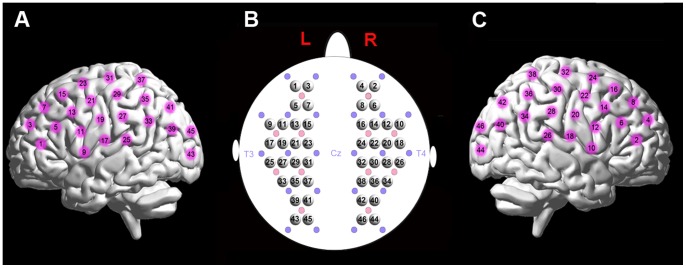
Schematic of fNIRS channel localization.(A) and (C) display the left and right view of measurement channels on an anatomical brain image. (B) The arrangement of the whole-head 46 measurement channels on a brain template. Note that the red and purple solid circles represent sources and detectors, respectively.